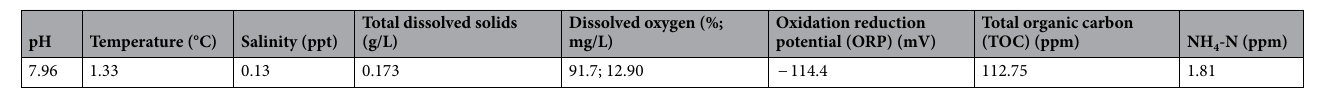
Table 1. Physico-chemical characteristics of the Allen Bay sea ice cryoconite collection site.